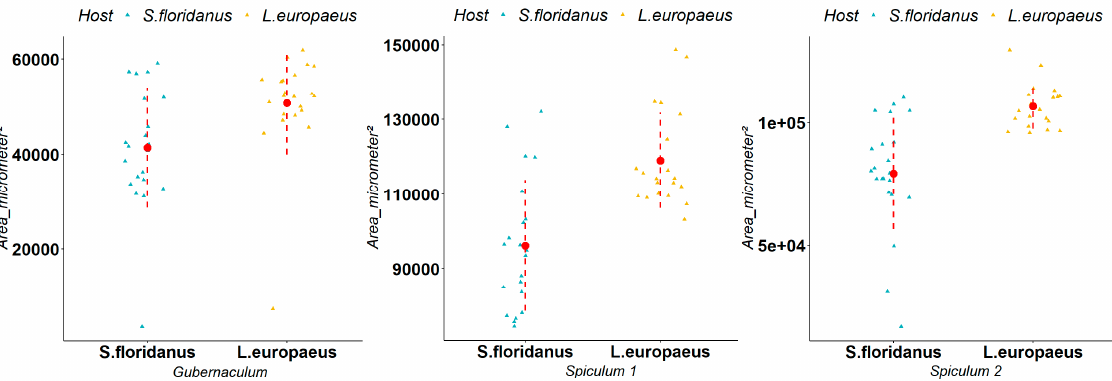
Figure 4. Comparison of the gubernaculum, spiculum 1 and spiculum 2 of Trichostrongylus calcaratus in Lepus europaeus and Sylvilagus floridanus (measurements shown in μ m 2 ). The triangles represent the single observations, the red dots represent the average values, while the red dashed lines represent the standard deviation.